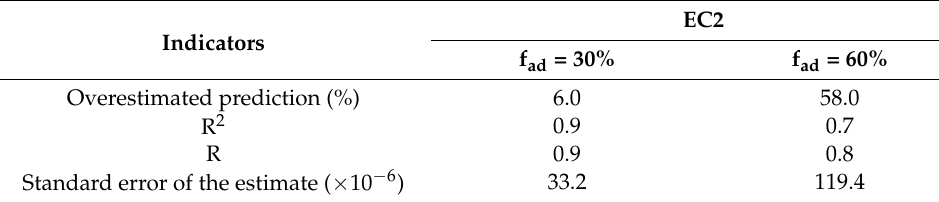
Figure 9. Total length of shrinkage over 91 days ( a ) and shrinkage calculated according to the EC2 prediction model ( b ). Table 7. Statistical indicators of the results calculated using the EC2 model.